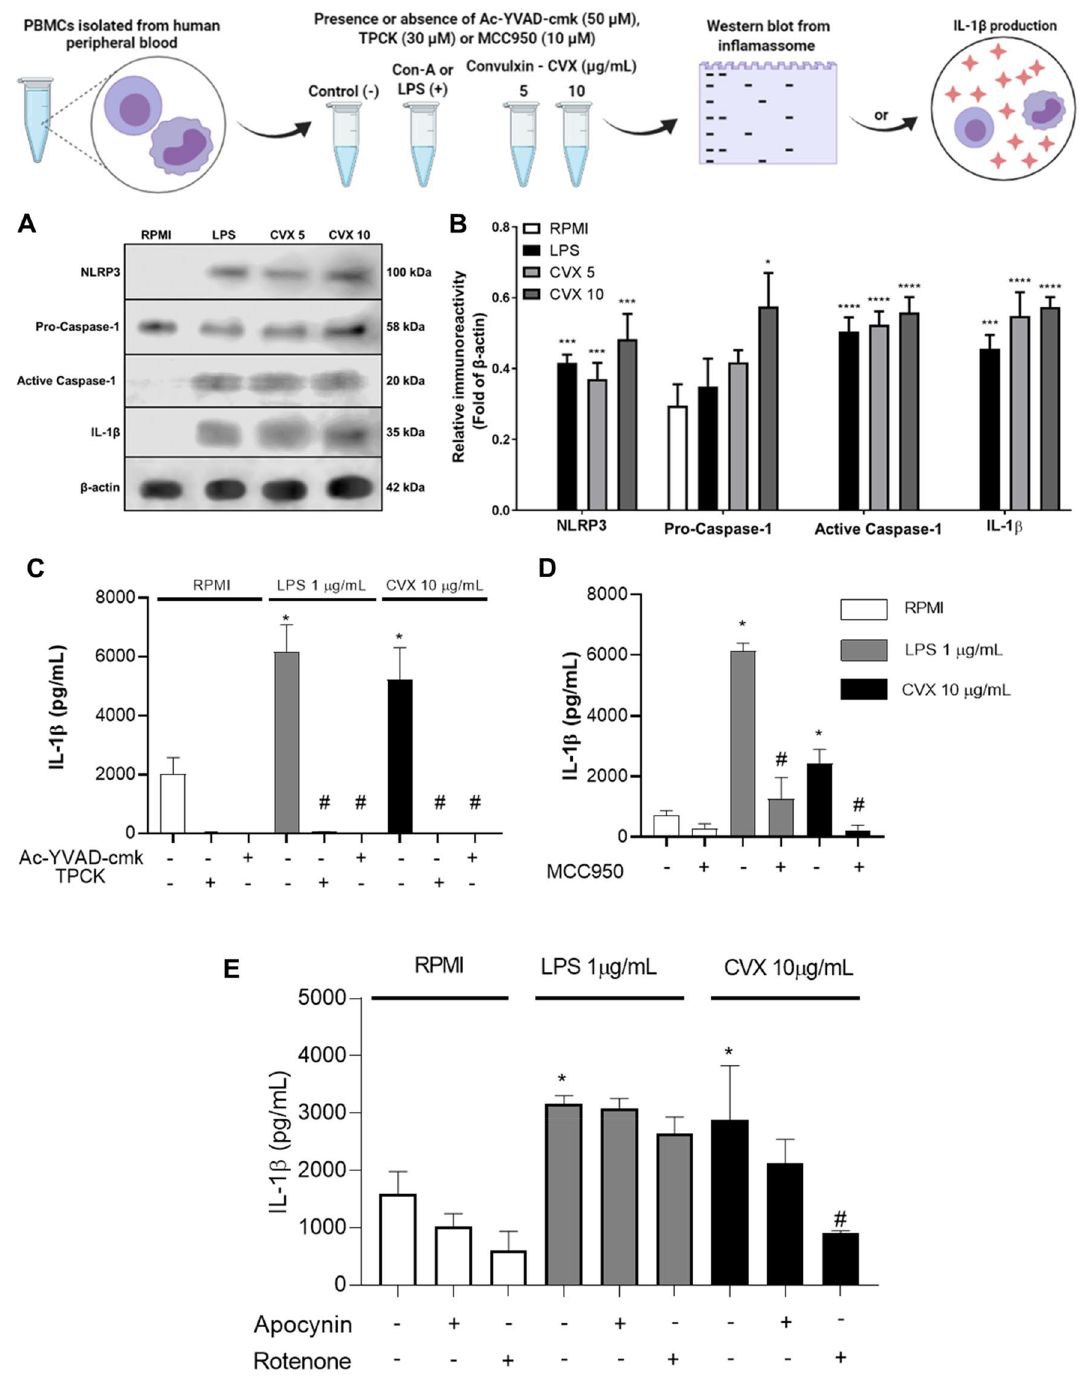
Figure 5. Protein expression of inflammasome NLRP3 in PBMCs in the presence of Convulxin. Western blot of NLRP3, Pro-Caspase-1, Active Caspase-1, IL-1β, and β-actin (control) using 1 × 10 7 PBMCs stimulated RPMI (negative control), LPS (1 μg/mL; positive control) or CVX (5 and 10 μg/mL) for 3 h. ( A ) Figure representative of one experiment of three independent experiments. Relative immunoreactivity analysis (fold of β-actin) of the western blots from NLRP3, Pro-Caspase-1, Active Caspase-1, IL-1β ( B ). IL-1β release was also quantified in PBMCs pretreated with N-tosyl-l-phenylalanine chloromethyl ketone (TPCK) (30 µM), Ac-YVAD-cmk (50 µM) ( C ), MCC950 (10 µM) ( D ) for 30 min and after incubated with RPMI (negative control) or CVX (10 µg/mL). IL-1β was also quantified in PBMCs pretreated with Apocynin (300 µM) and Rotenone (10 µM) for 30 min and after incubated with RPMI (negative control) or CVX (10 µg/mL) ( E ). Results were expressed in pg/mL of released cytokines and represent the mean ± S.E.M of 3 donors. Values are mean S.E.M. from 3 donors. *P < 0.05, **P < 0.01, ***P < 0.001, ****P < 0.0001 compared to negative control (data were presented with ANOVA followed by Dunnett